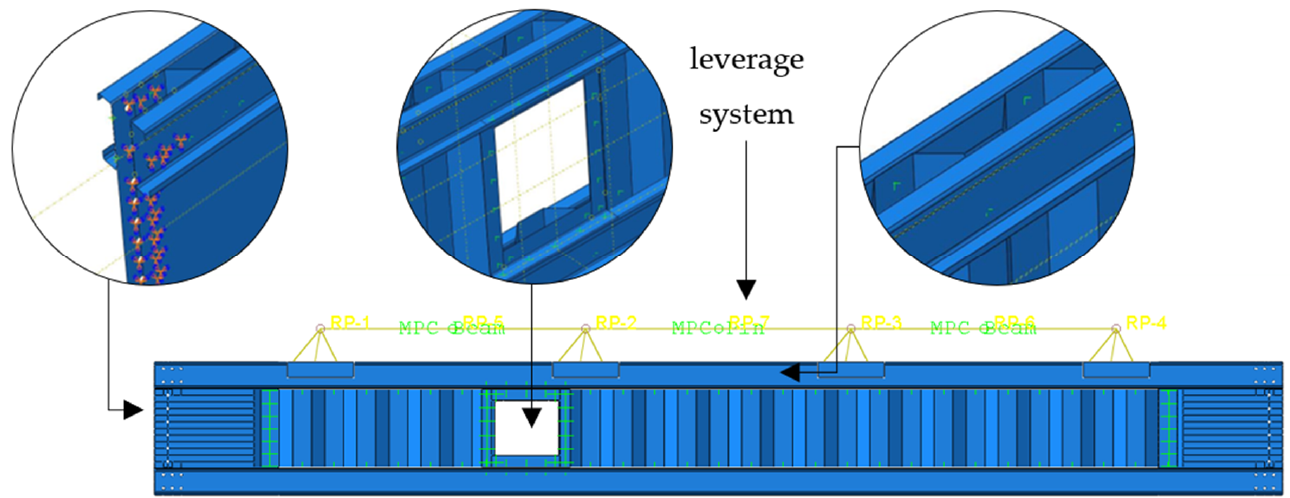
Figure 9. The FE